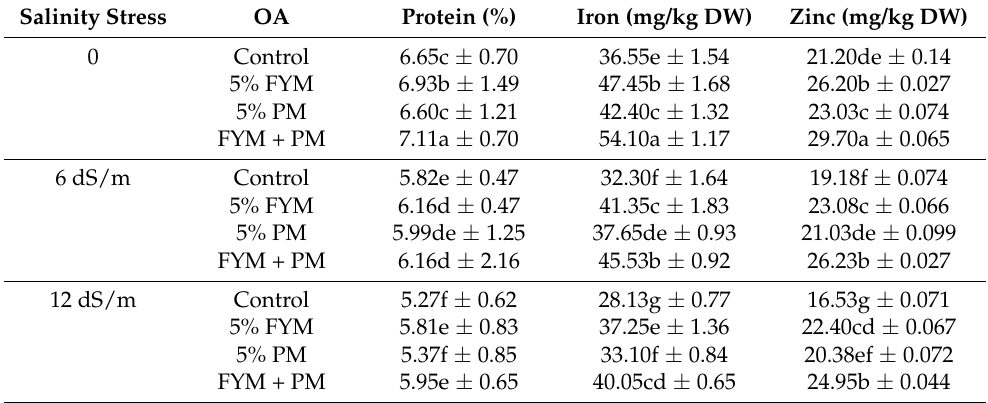
Table 5. Effect of different organic amendments on grain quality traits under diverse salt stress levels. Salinity Stress